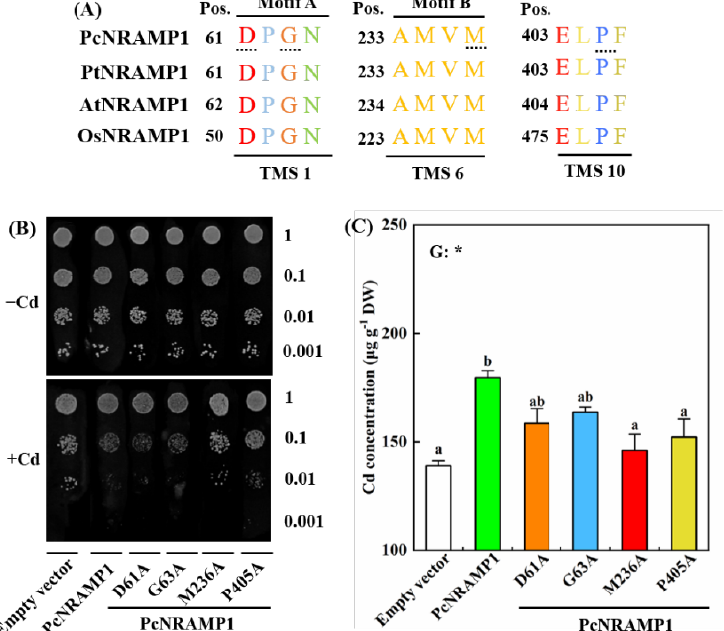
Figure 7. Transport activities of Cd of mutated PcNRAMP1 in yeast. ( A ) Sequence alignment of different transmembrane segments of PcNRAMP1 and its homologous proteins in P. trichocarpa (Pt), A.thaliana (At), and O.sativa (Os). TMS: transmembrane segments. Dashed line in panel ( A ): selected mutation sites. ( B ) The growth status of ∆ ycf1 transformed with empty vector, PcNRAMP1 , and the mutated PcNRAMP1 ( PcNRAMP1 D61A , PcNRAMP1 G63A , PcNRAMP1 M236A and PcNRAMP1 P405A ) under 0 ( −Cd) or 30 μM (+Cd) CdCl 2 for 4 days. ( C ) Cd concentration in yeast cells transformed with mutated PcNRAMP1 . Bars indicate means ± SE (n = 4). Different letters on the bars indicate significant differences. The p -value of the one-way ANOVA of genotypes (G) is also indicated. *: p < 0.05.